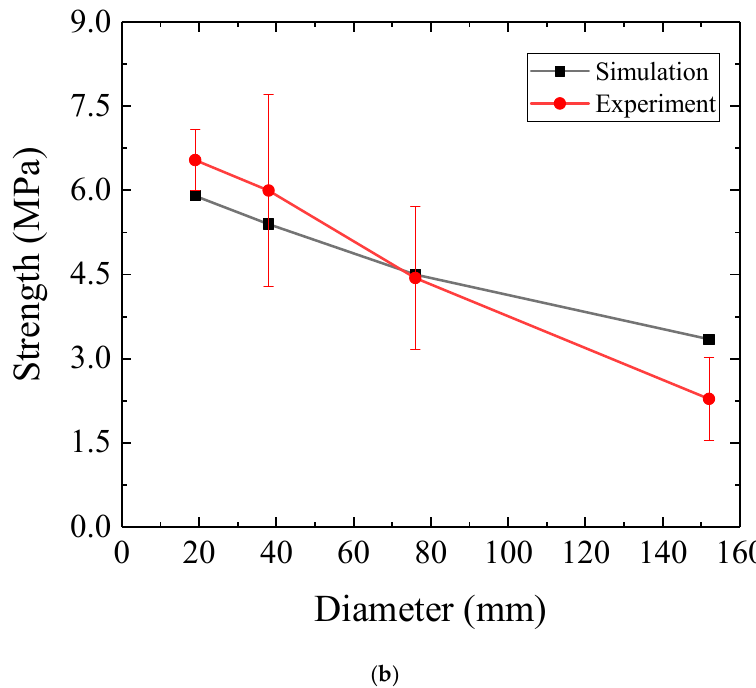
Figure 8. ( a ) Comparison between numerical results and experimental results, ( b ) typical stress-displacement curve for tensile splitting tests.